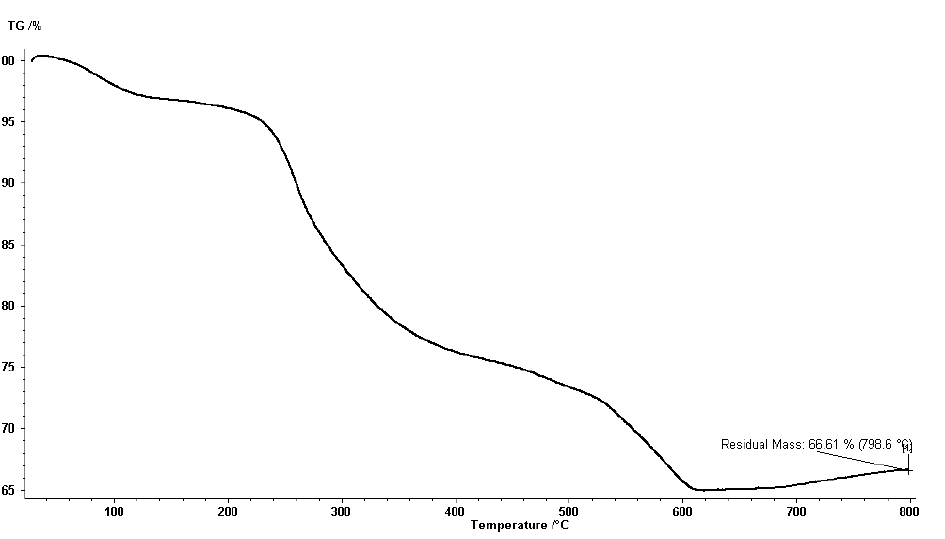
Figure 3. Field emission scanning electron microscopy (FESEM) image of the NiFe 2 O 4 -NPs.